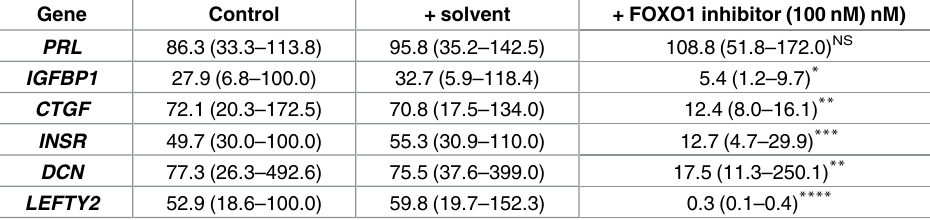
Table 1. Comparison of relative levels in the presenceor absence of FOXO1 inhibitor in decidualizing endometrial stromal cells.